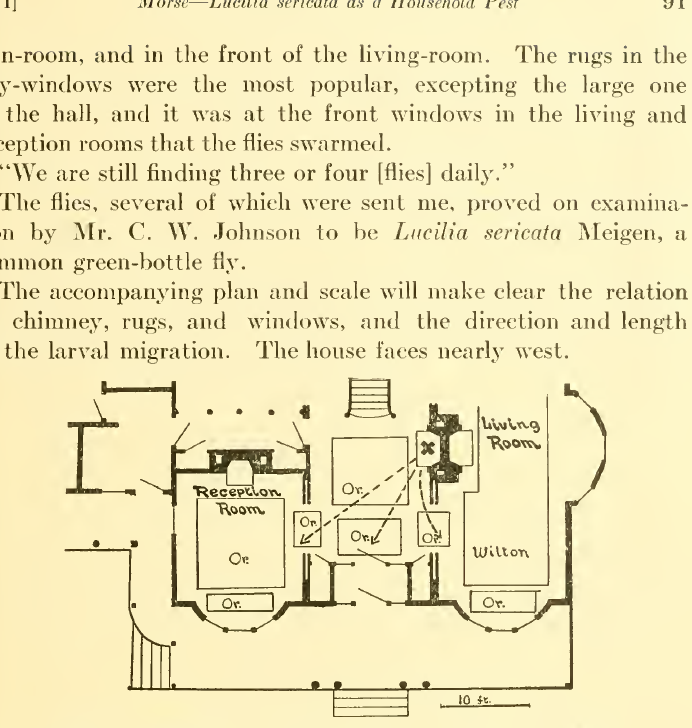
Fig. 1. X = fireplace of squirrel's chimney. The maggots were most numerous under the oriental rugs in the front of the hall and in the two bay windows at front of